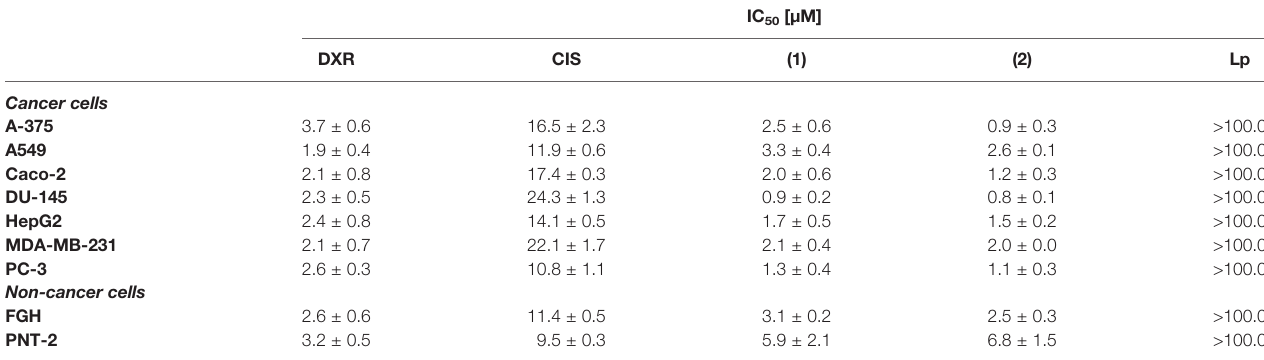
TABLE 1 | Cytotoxic activity of lapachol-containing ruthenium